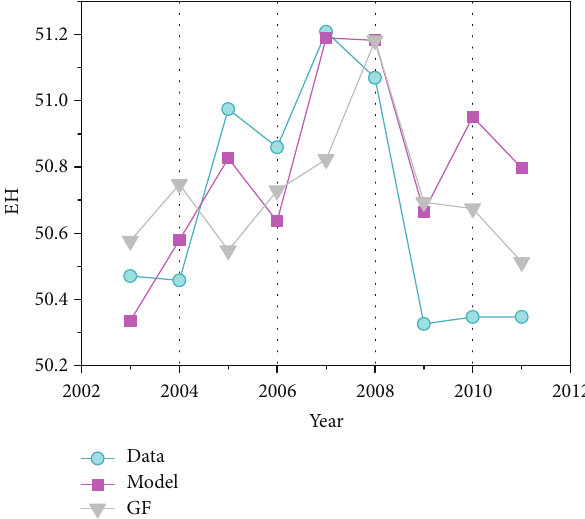
Figure 5: Earthhealth (EH)tendency comparisonsfor (1) empirical data, (2) our model, and (3) for Gaussian Fitting